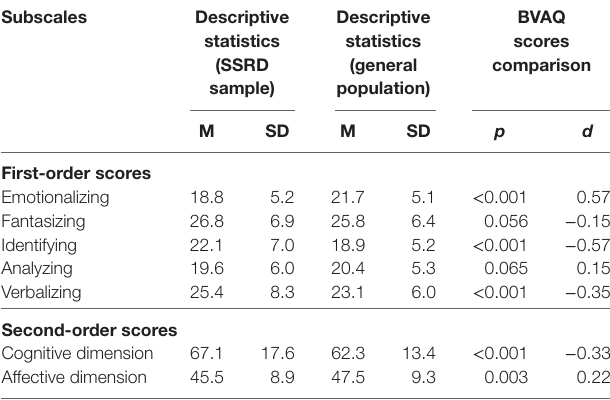
TaBle 6 | Descriptive statistics, of the first-order and second-order scores of the BVAQ (results obtained in the total sample), descriptive statistics for the SSRD sample ( N = 234) and statistical comparison between SSRD sample and general population of BVAQ scores.